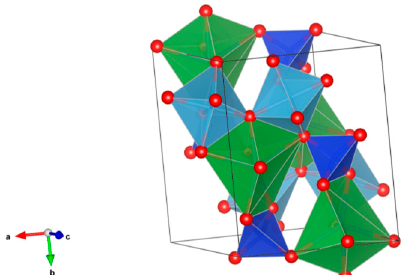
/ a. Cations can be